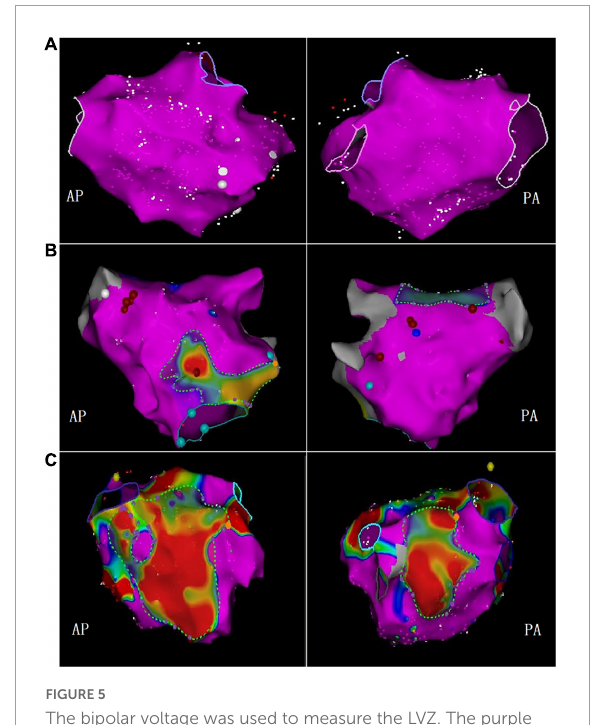
FIGURE5 The bipolar voltage was used to measure the LVZ. The purple area represented the standard atrial matrix, and the color area represented the LVZ area. (A) No LVZ; (B) mild LVZ; (C) severe LVZ (AP, anterior-posterior position; PA, posterior-anterior position).